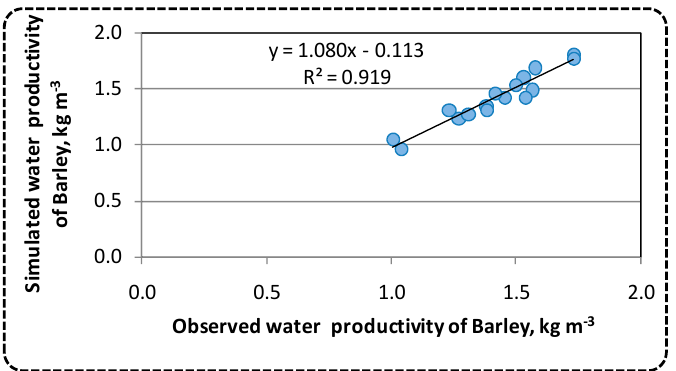
Figure 17. Observed versus simulated water productivity barley for the 2017/2018 and 2018/2019 seasons for all treatments.